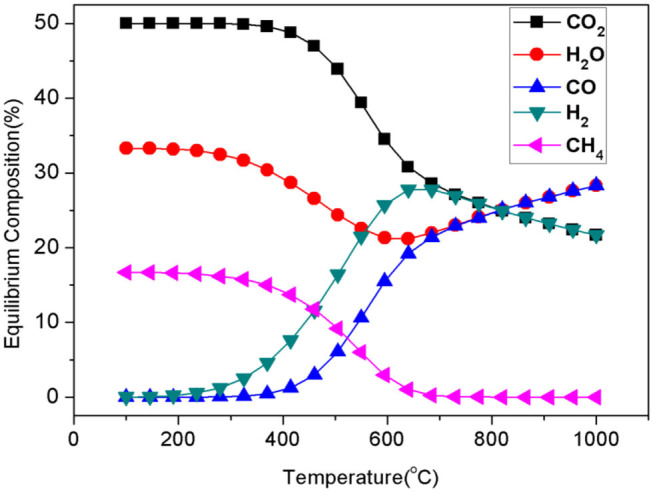
Equilibrium composition of the RWGSR and CO2 methanation (CO2:H2 = 1:1).